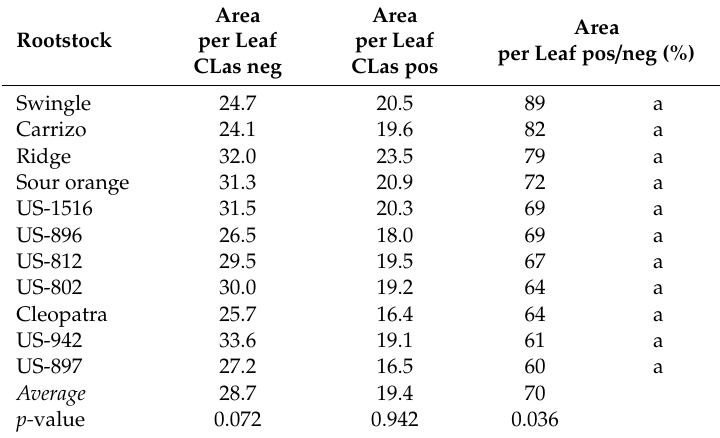
Table 9. Area per leaf (cm 2 ) at 50